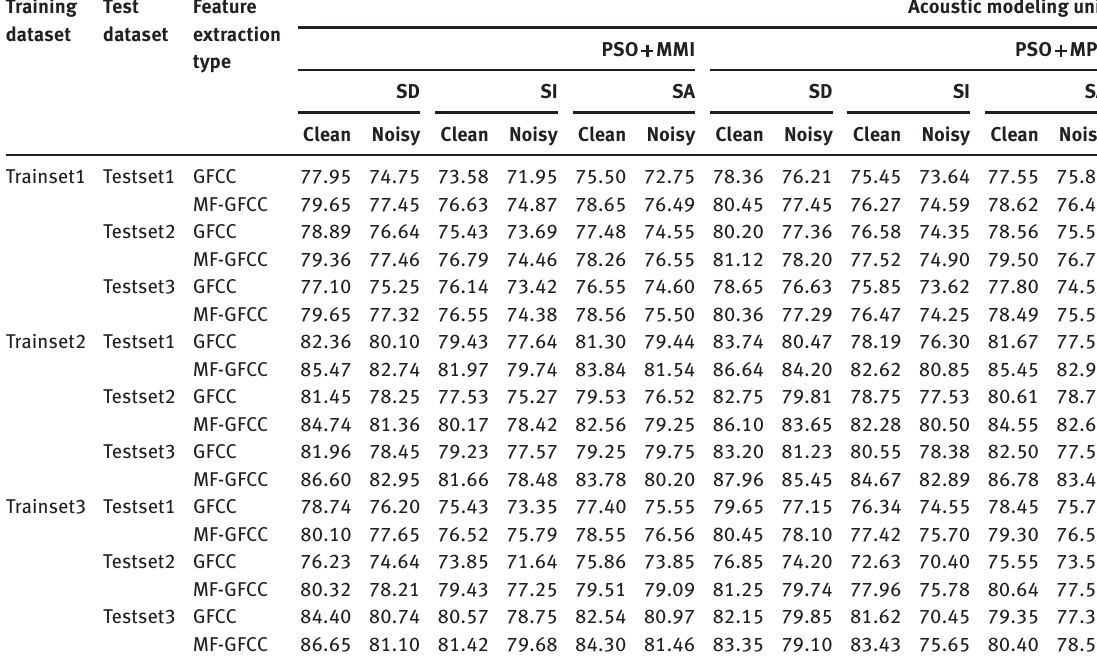
Table 4: Comparative Analysis Using Different Speaker Variations. Training